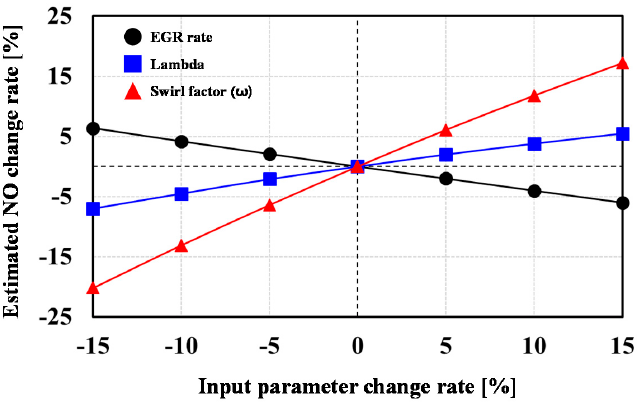
Figure 7. Results of the sensitivity analysis for all operating points in engine A-aged ( n = 220).